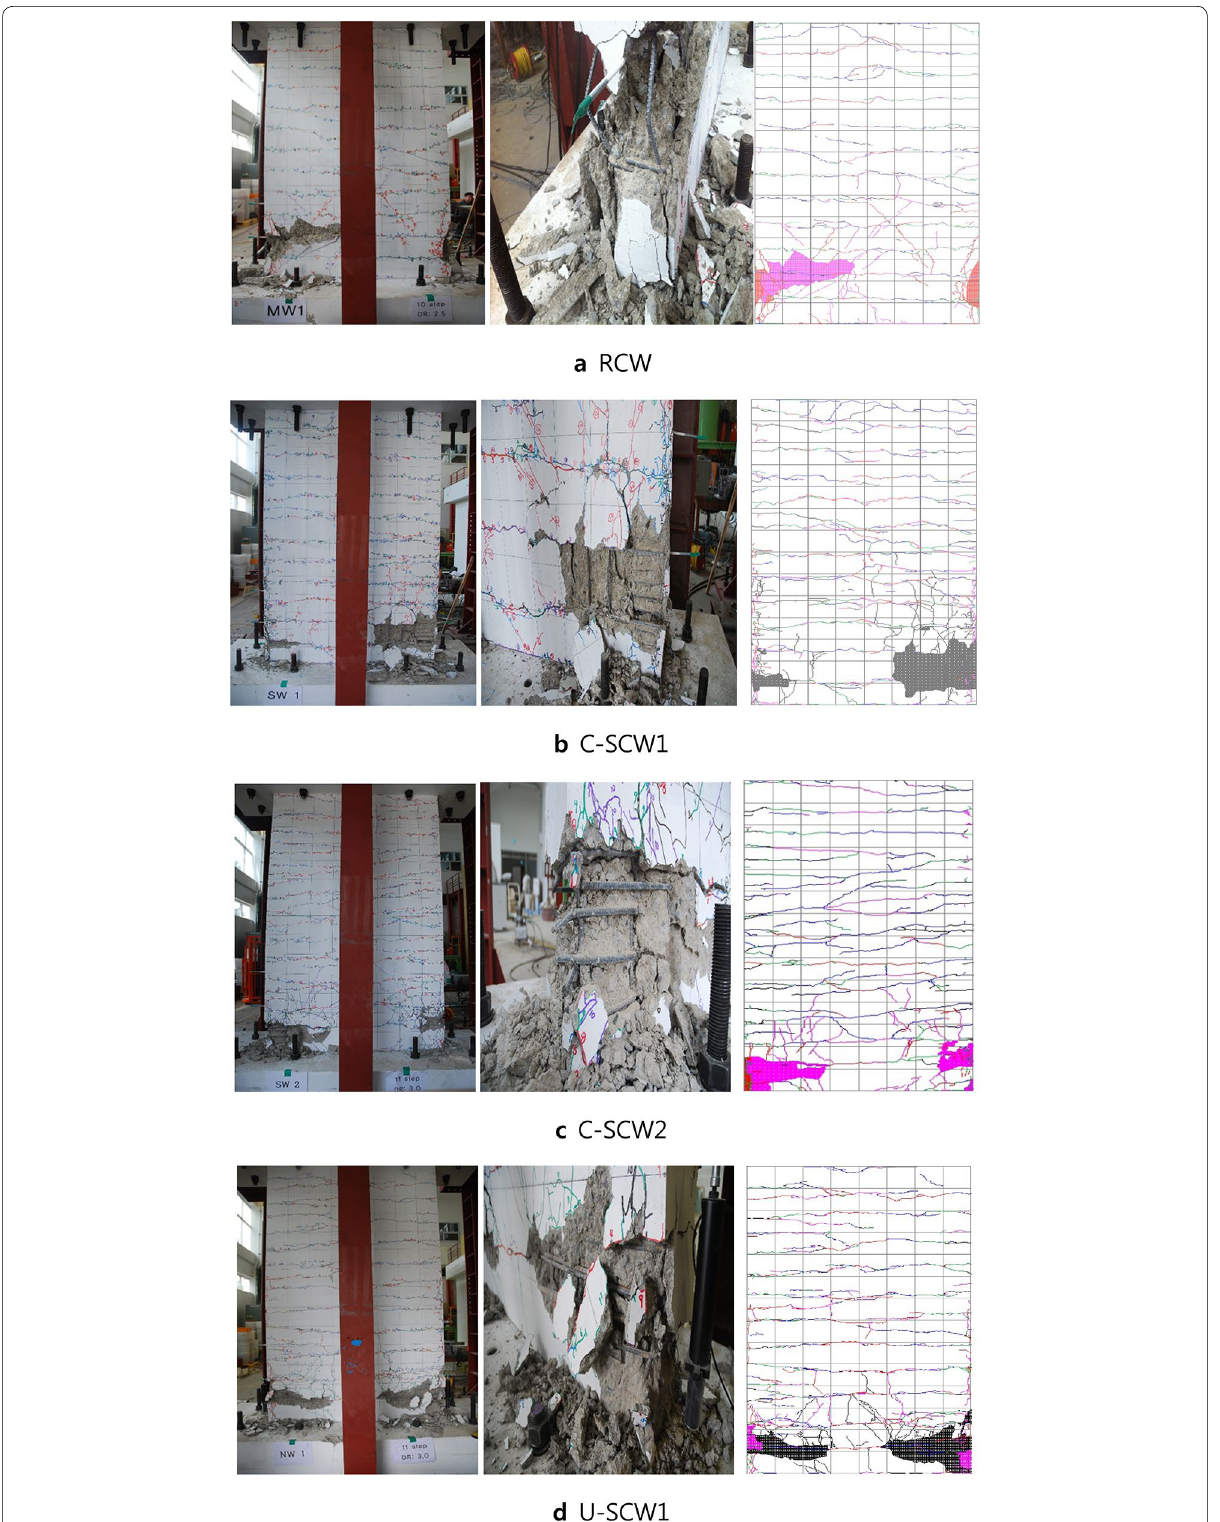
Fig. 10 Final cracks and damage